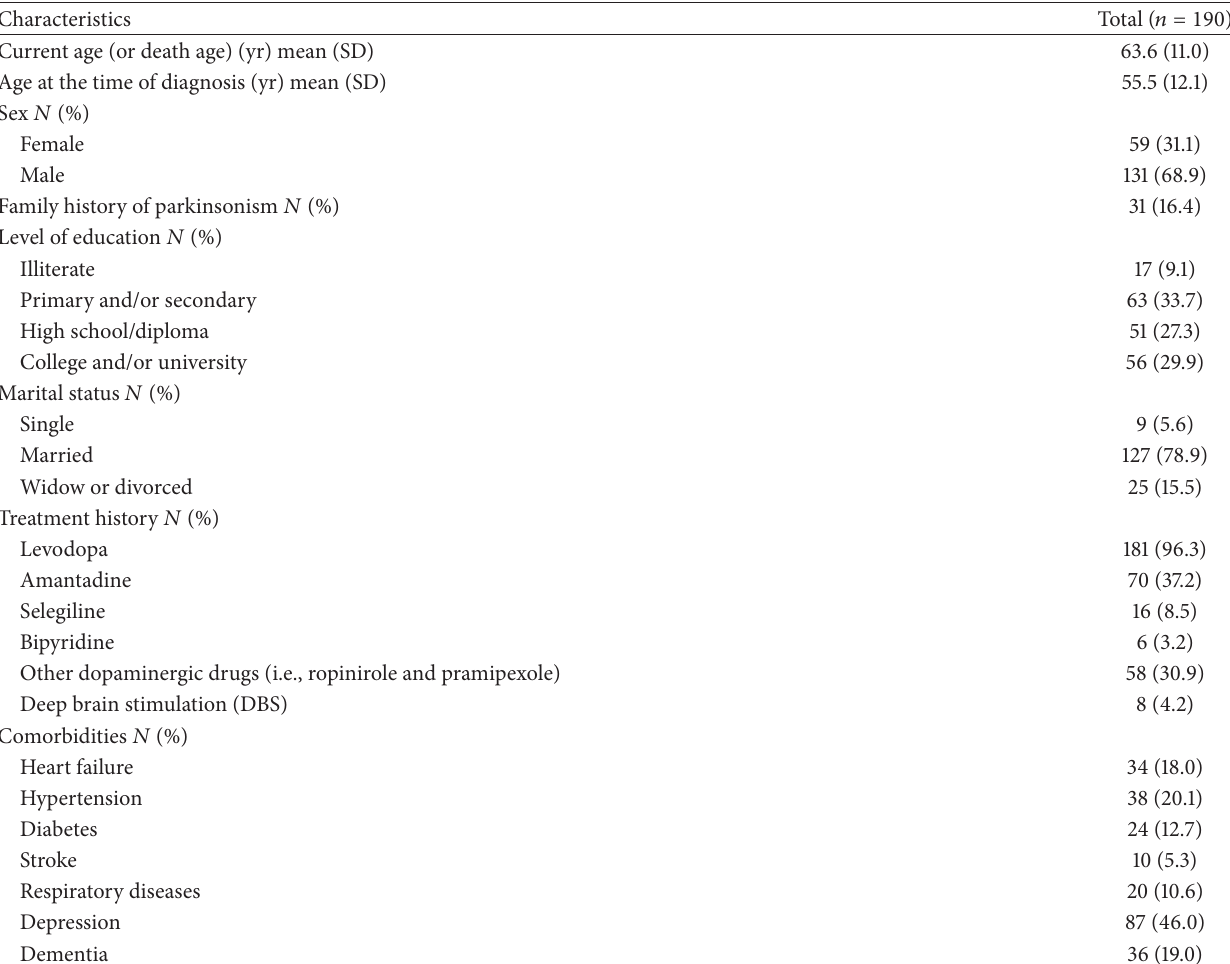
Table 1: Baseline and clinical characteristics of the recruited Parkinson’s disease patients. Characteristics